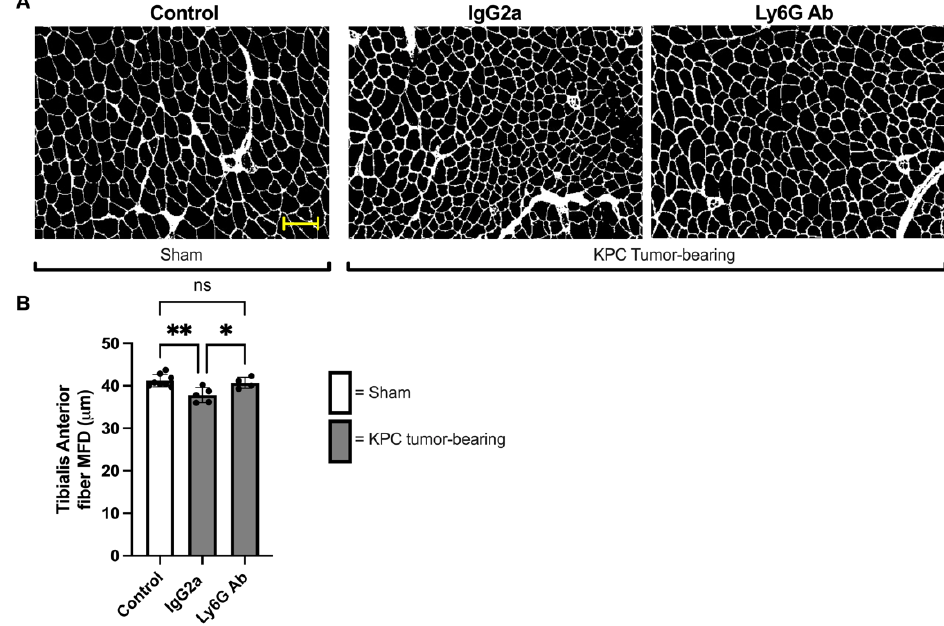
Figure 5. The depletion of Ly6G+ cells protects against orthotopic KPC-induced muscle fiber atrophy. ( A ) Representative images of TA muscle cross-sections from Sham and KPC tumor-bearing mice stained with WGA to outline muscle fiber borders. Scale bar = 100 µ m. ( B ) Average TA muscle fiber size, based on quantification of minimum Feret’s diameter (MFD). All intact muscle fibers of the TA muscle were measured. Control: n = 8; IgG2a n = 5; Ly6G Ab: n = 4. * = p < 0.05; ** p < 0.01; ns = not significant ( p > 0.05).